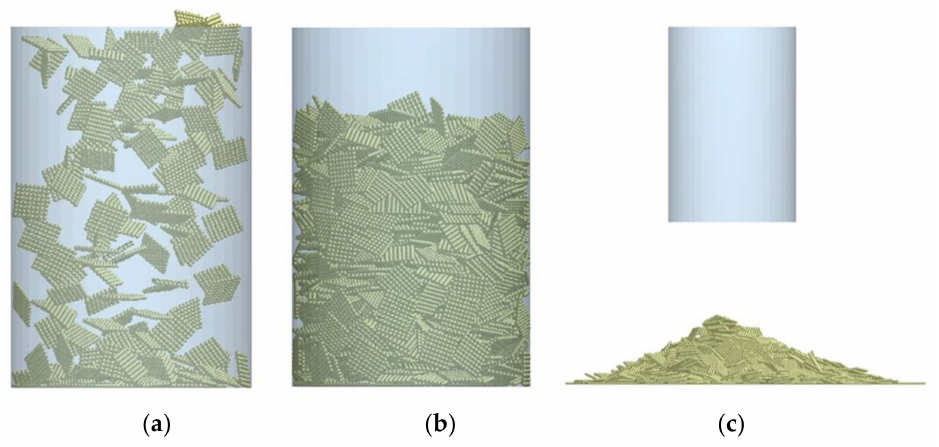
Figure 6. Angle of repose simulation test process: ( a ) particle filling, ( b ) system reaches stability, ( c ) stable stack.